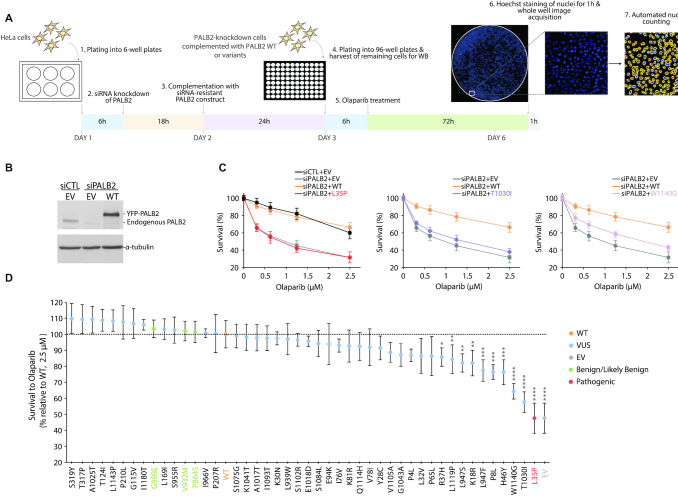
Sensitivity of PALB2 variants to PARP inhibitor olaparib. PALB2-knockdown HeLa cells, previously transfected with the empty vector (EV) or a siRNA-resistant PALB2 construct (either wild-type (WT) or variant), were seeded into 96-well plates and exposed to olaparib concentrations ranging from 0 to 2.5 μM. Cell viabilities were obtained 72 h post-treatment by quantification of surviving Hoechst-stained nuclei and represented as percent survival relative to the control (DMSO-treated) condition. (A) Schematic representation of the strategy employed for testing olaparib sensitivity. (B) Typical levels of PALB2 after knockdown and re-expression in HeLa cells, with tubulin as loading control. (C) Survival curves contrasting the abilities of PALB2 WT and the p.L35P, p.T1030I and p.W1140G variants to rescue olaparib resistance in PALB2-knockdown cells. (D) Olaparib sensitivity profiles for the complete set of variants at a concentration of 2.5 μM, with the WT condition set at 100%. PALB2 variants are classified in descending order of olaparib sensitivity and survival data are presented as the mean (± SD) from at least 3 independent experiments, each performed in triplicate. Statistical significance was determined by Kruskal–Wallis test with Dunn's multiple comparison post-test. (*) P< 0.05; (**) P< 0.01; (***) P< 0.001 and (****) P< 0.0001.